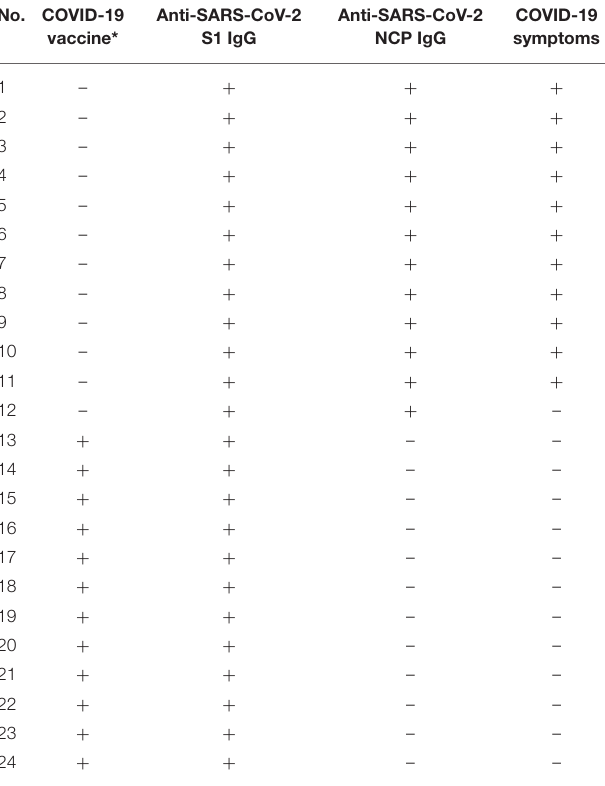
TABLE 1 | Characteristics of anti-SARS-CoV-2 IgG-positive